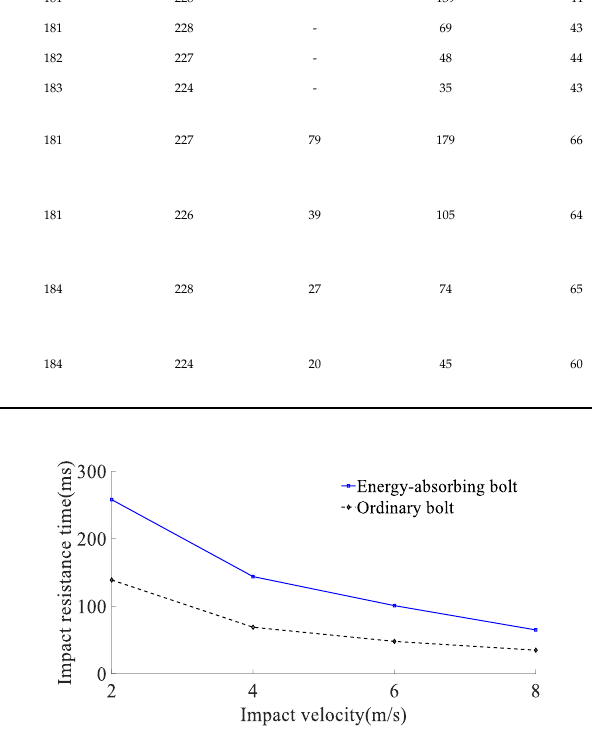
Figure 13. Anchor impact resistance time at different impact velocities.